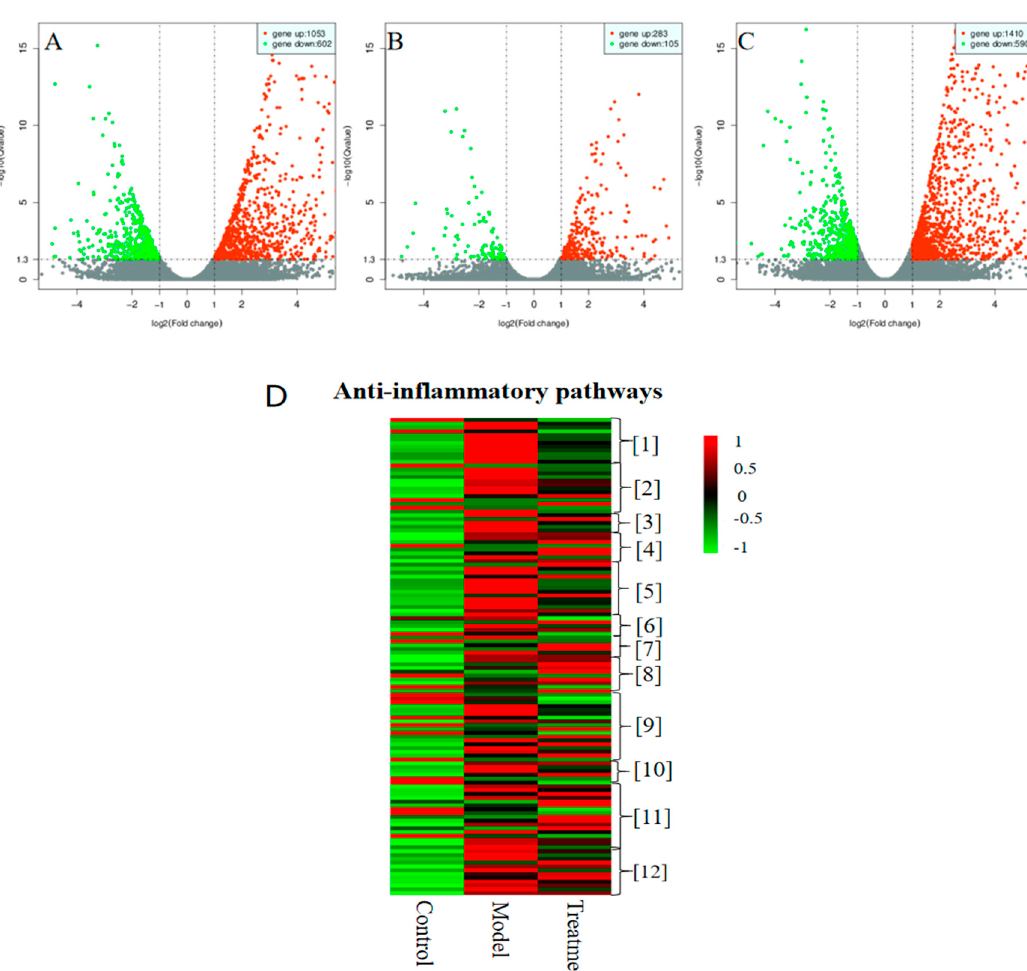
Figure 1. DistincttranscriptomeprofileobtainedupontreatingRAW264.7macrophageswithchlojaponilactone B ( 1 ), as determined by RNA-seq. Horizontal coordinates represent variations in mRNA expression levels, and longitudinal coordinates represent significant changes in mRNA expression levels. Red and green dots in the Volcano plot indicate mRNAs with increased and decreased expression levels, respectively. Red and green squares in the Heat map indicate mRNAs with increased and decreased expression levels, respectively (see color scale). RAW 264.7 macrophages treated with LPS (1 µ g / mL) for 24 h served as the model group and those treated with 1 (3.5 µ M) and LPS (1 µ g / mL) served for 24 h as the treatment group. Cells cultured with 0.05% DMSO for 24 h served as the control group. ( A ) Control group vs. model group. ( B ) Model group vs. treatment group. ( C ) Control group vs. treatment group. ( D ) Heat map analysis of anti-inflammatory